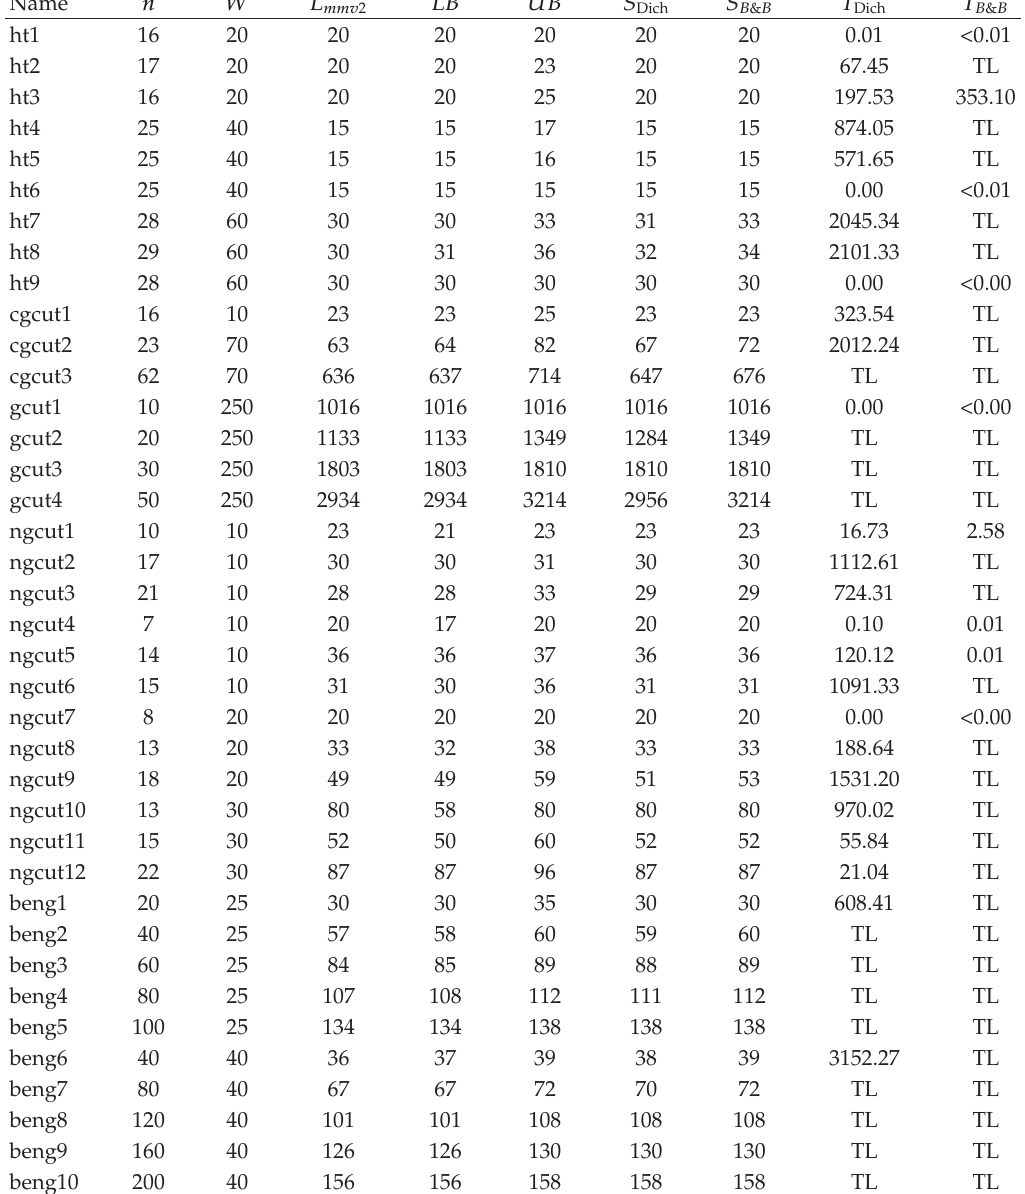
Table 3: Results of exact algorithms on literature